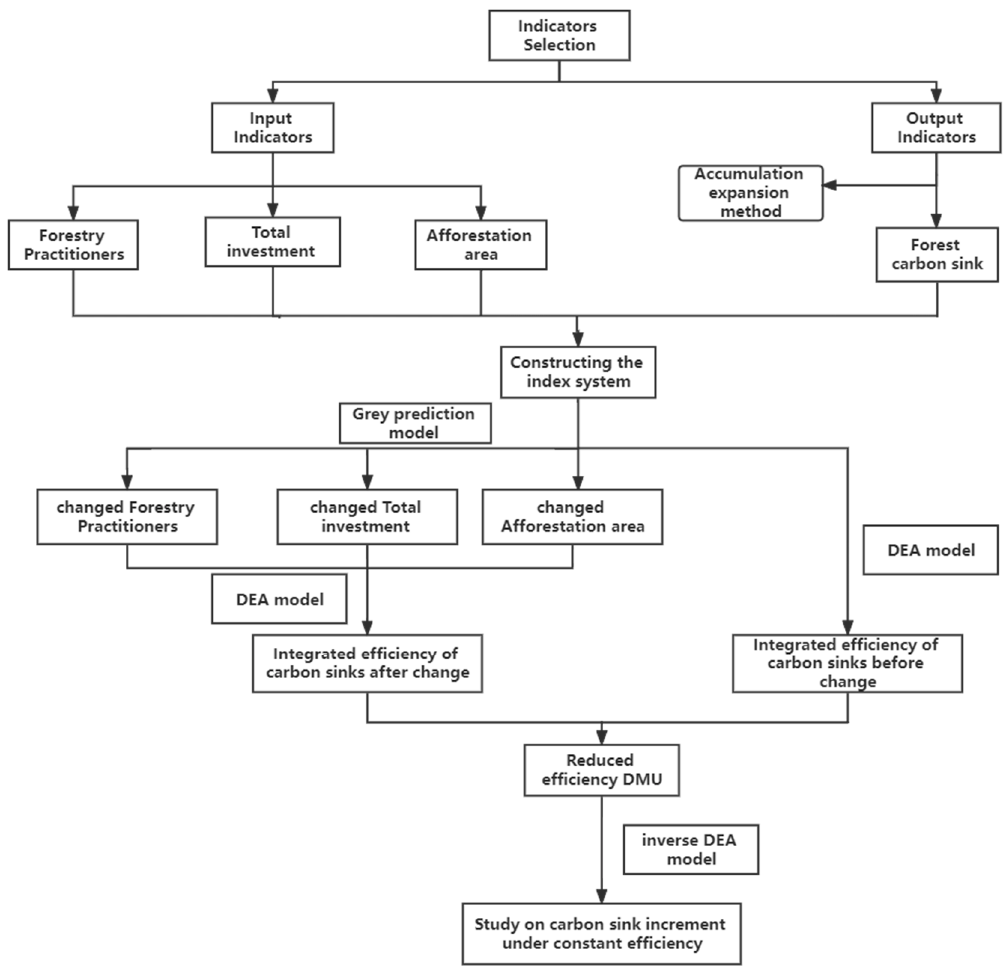
Figure 1. Flow chart of carbon sink inker.